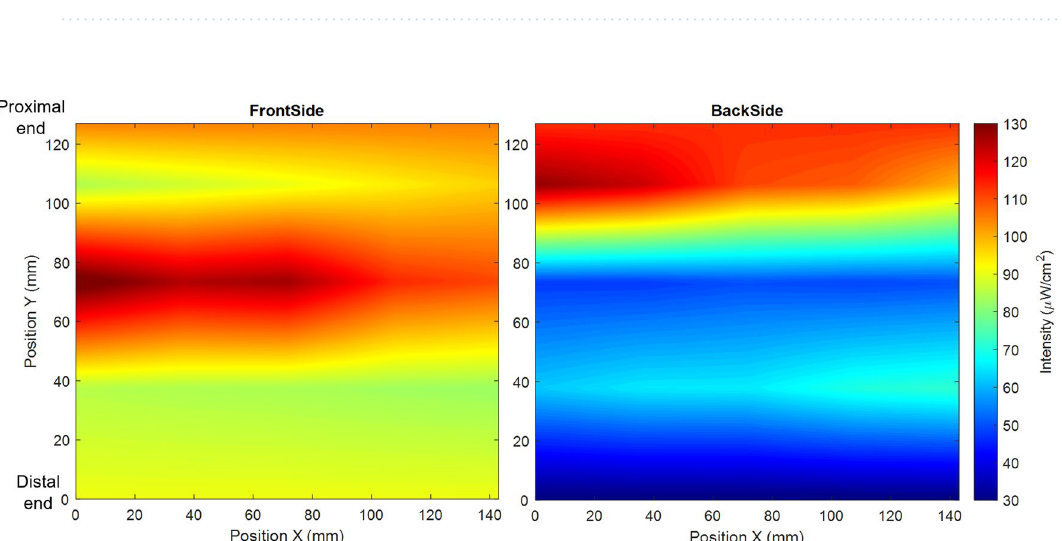
Table 1. Experimental resistance and calculated intensity values at 18 different locations on the face covering.